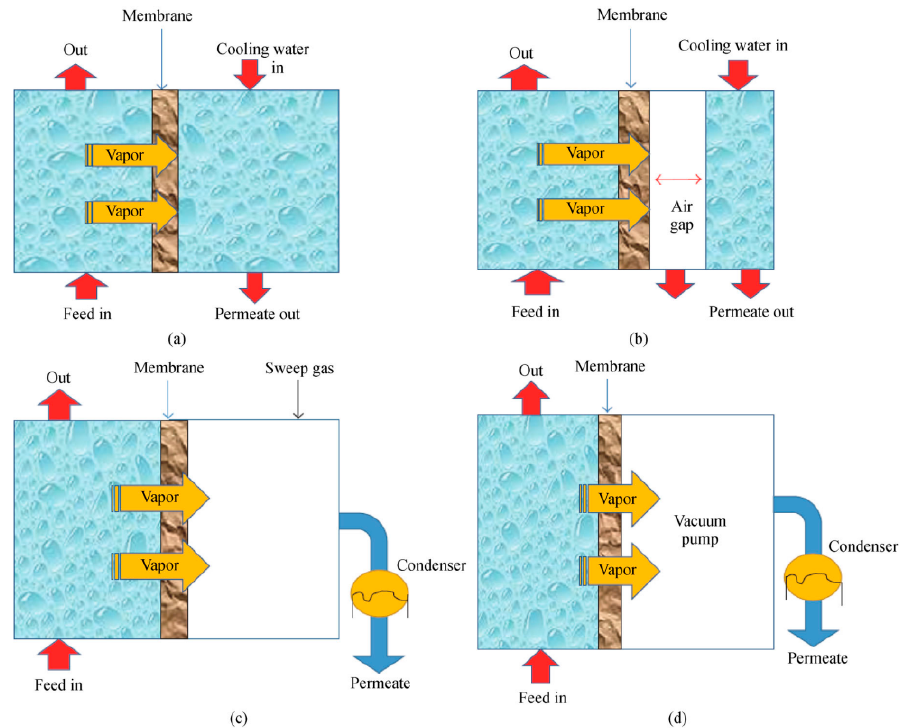
Figure 1. Membrane distillation basic configurations: ( a ) Direct contact membrane distillation (DCMD); ( b ) Air gap membrane distillation (AGMD); ( c ) Sweep gas membrane distillation (SGMD); ( d ) Vacuum membrane distillation (VMD). Reprinted from ref. [45] (Open access).